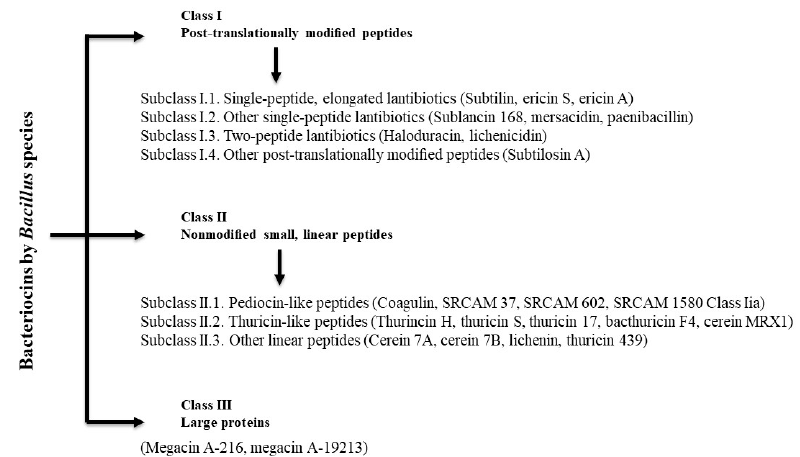
Figure 1. Classification of bacteriocins produced by Bacillus species (based on Abriouel et al. [81]).